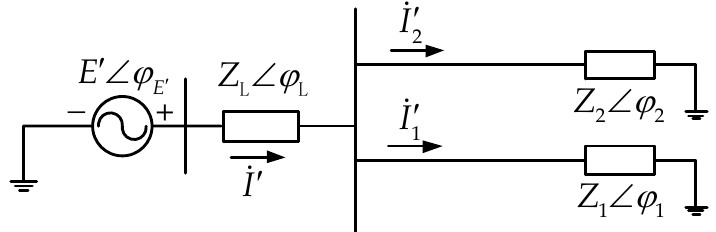
Figure 3. Equivalent circuit when the system source acts alone; E (cid:48) ∠ ϕ E (cid:48) is the grid voltage after the voltage sag occurs, 1 , 2 are the currents of the sensitive load and the adjacent load respectively without DVR after voltage sag, I is the current supplied by the system source to the loads after voltage sag.